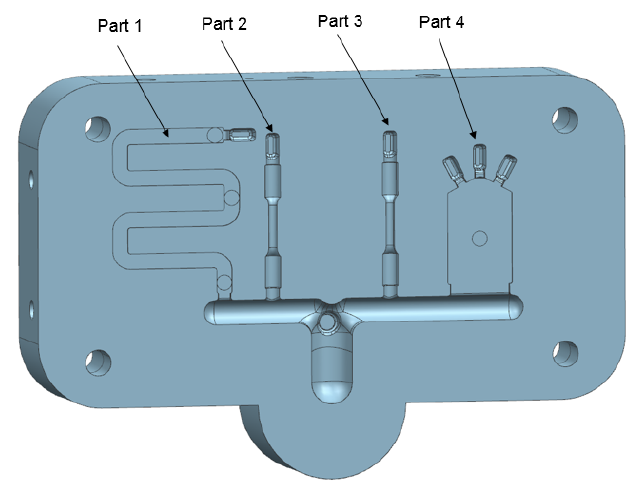
Figure 7. Moving cavity unit of the mold used.